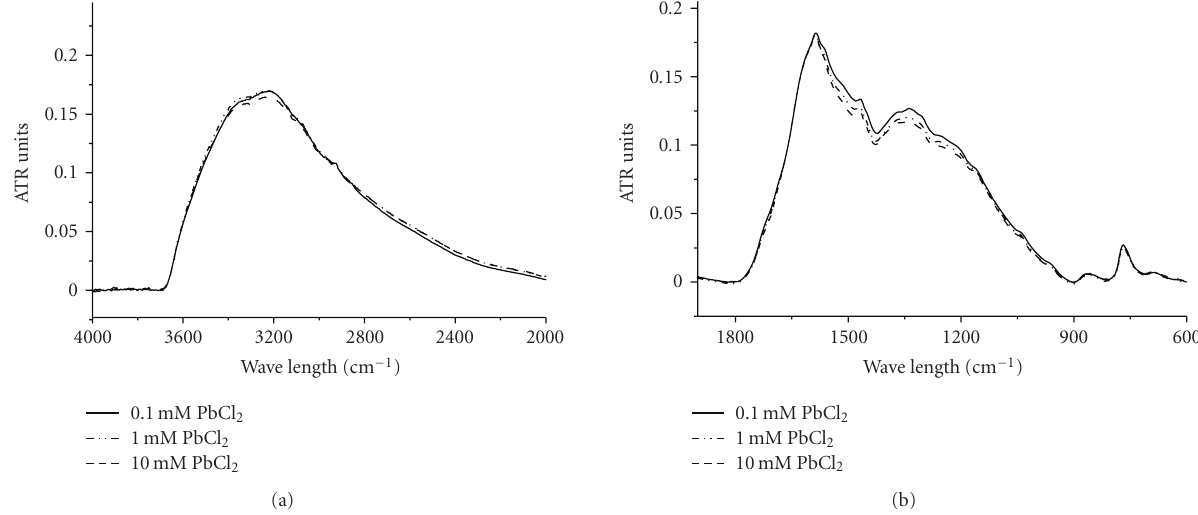
Figure 4: IR spectrum of heavy metal enriched squid melanin as a function of the solution concentration of Pb(II) in spectral region of (a) 900–1900 cm − 1 ; (b) 2000–4000 cm − 1 . The spectra are normalized to the intensity of the 1598 cm − 1